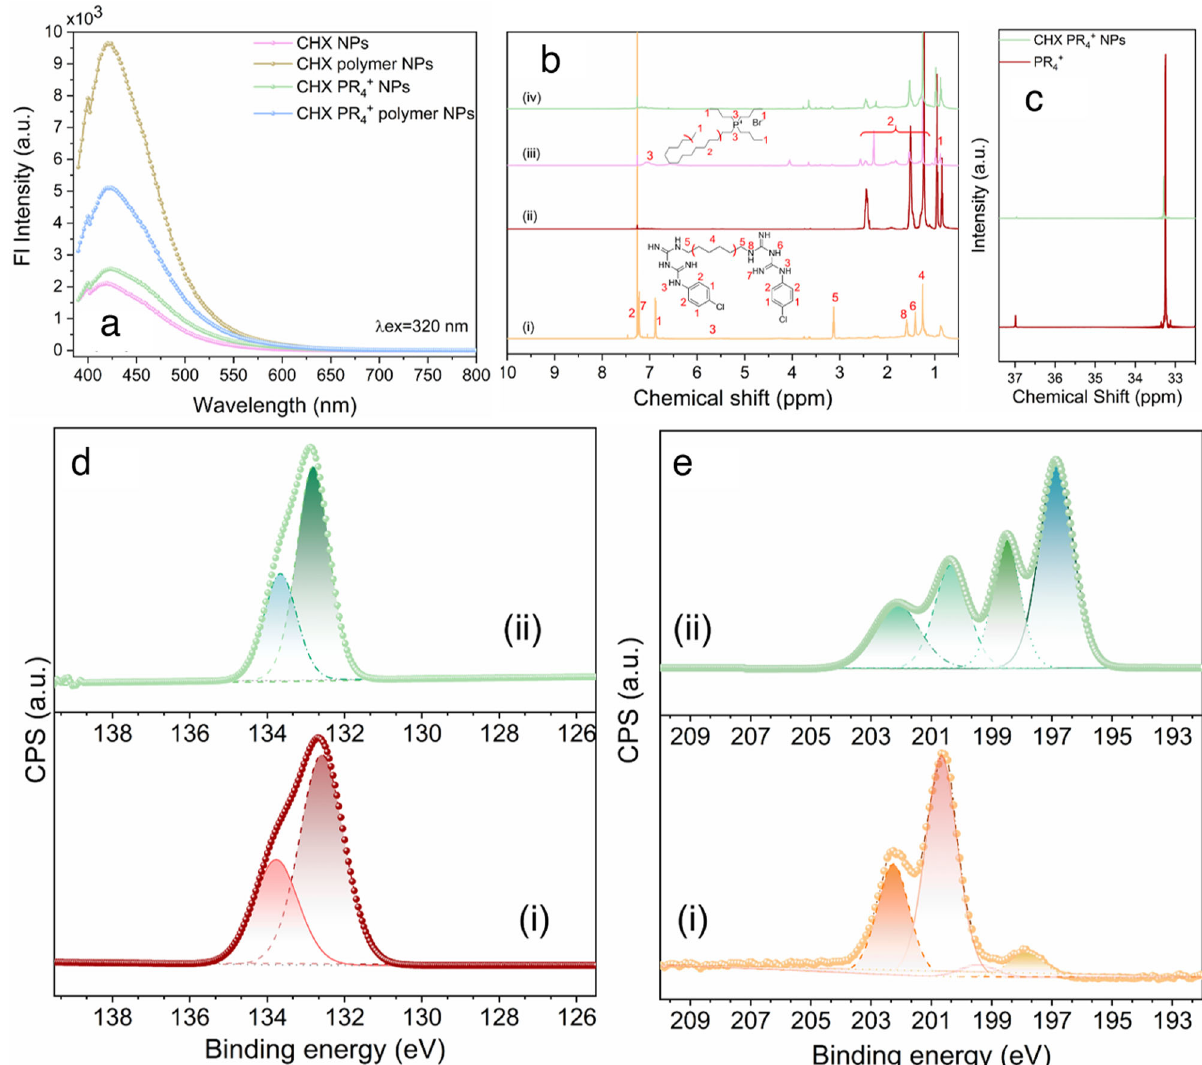
Fig. 2 Characterization of chemical properties of NPs. a Fluorescence emission spectra of the NPs with and without polymer wrapping with λ ¼ 320nm. The signal from the CDots is preserved and enhanced when wrapped in the polymer shell; b 1 H NMR spectra of (i) CHX, (ii) CHX NPs, excitation (iii) PR 4 + compound, and (iv) CHX PR 4 + NPs and the corresponding assignments; c 31 P NMR spectra comparing the phosphonium compound and CHX PR 4 + NPs; d XPS spectra in the P-binding region of (i) phosphonium compound (PR 4 + ) and (ii) CHX PR 4 + NPs, which showed similar peaks; e XPS spectra in the Cl-binding region for (i) chlorhexidine (CHX) and (ii) CHX PR 4 + NPs, which showed noticeable changes in the chemical